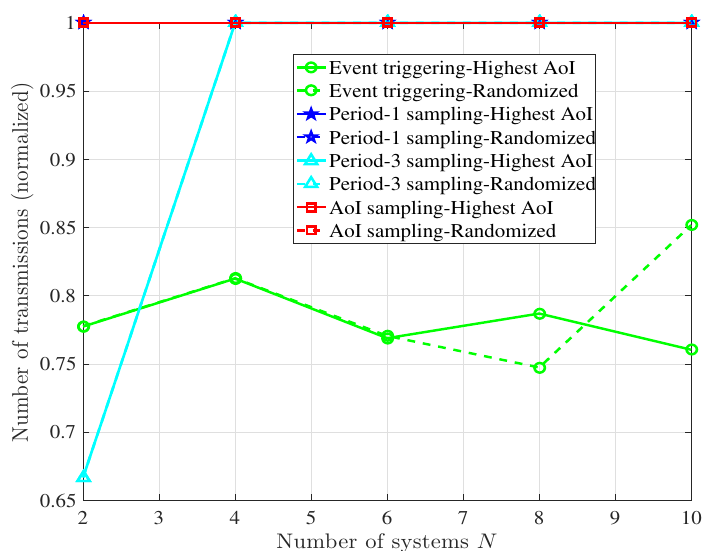
Figure 6. Normalized total number of network transmissions under different schemes.